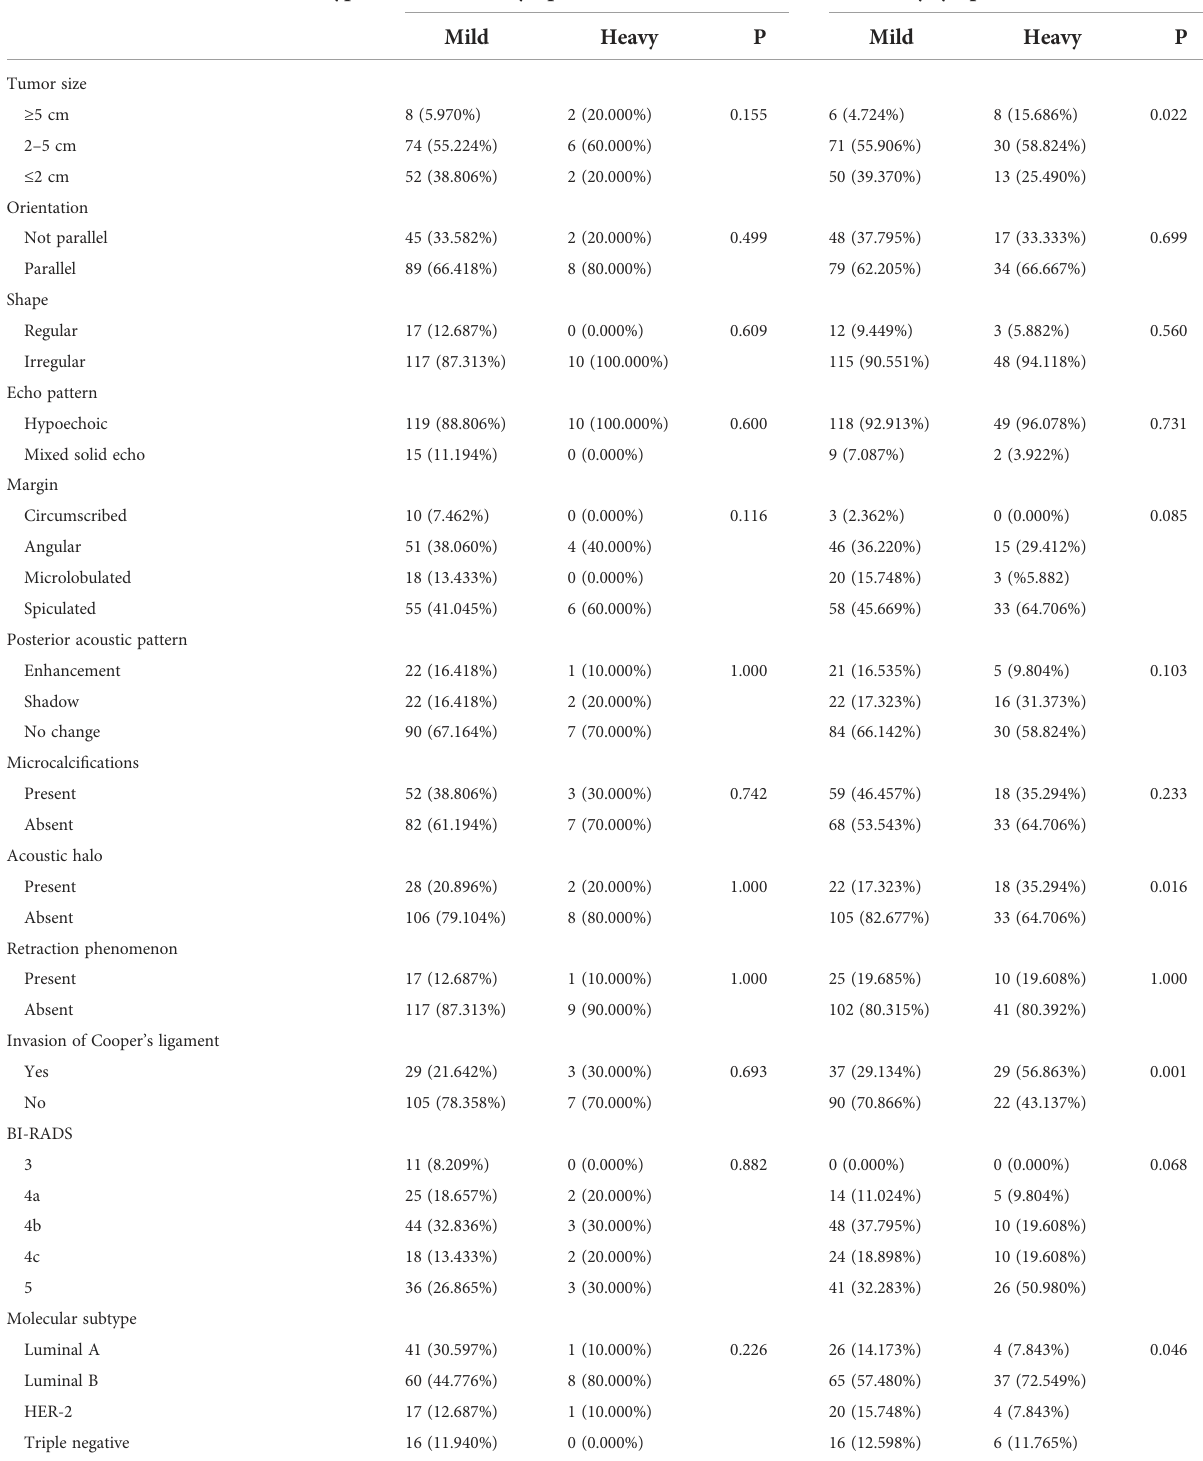
TABLE 1 Difference of lymph node tumor burden in the ABVS features and molecular subtypes of different breast